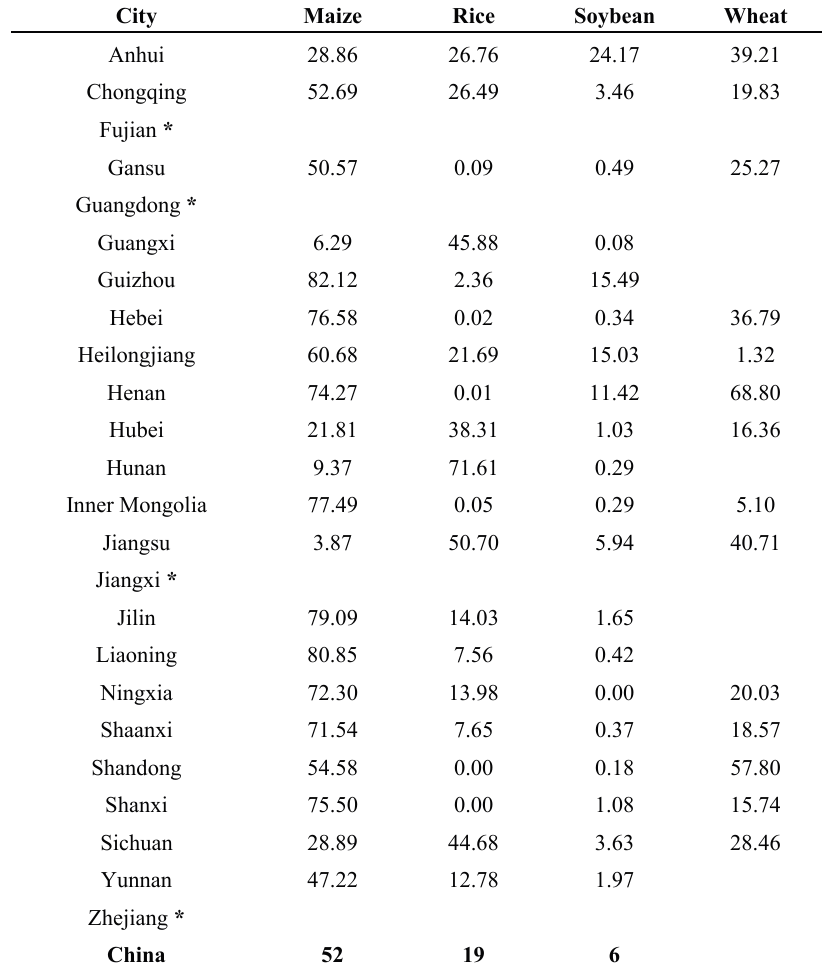
Table 2. Crop type proportion for China 2013. Note: The numbers indicate the percentage of the area cultivated under maize, rice, and soybean during early July and early October, and under wheat during mid-May in 2014. The difference between 100 percent and the sum of maize, rice, and soybean per province is “other summer crops”. * Fujian, Guangdong, Jiangxi, and Zhejiang were not sampled because rice is by far the dominant crop among the four major crops . City Maize Rice Soybean